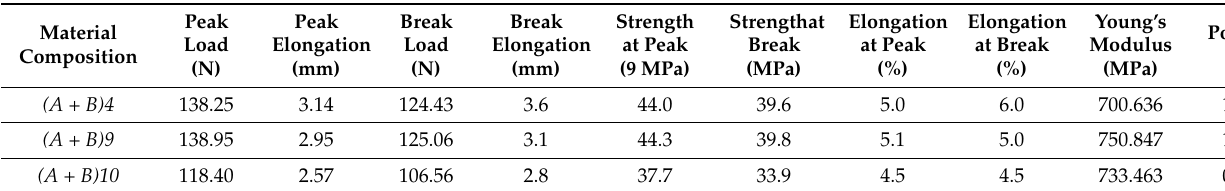
Table 10. Tensile testing of A + B copper and ABS at different proportions.